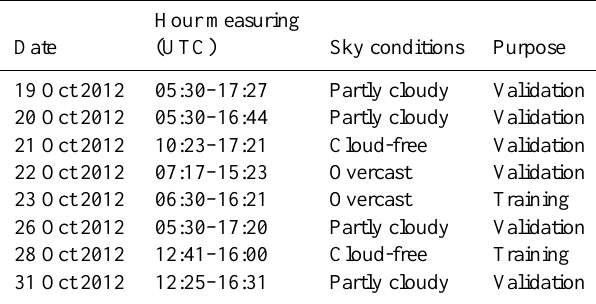
Table 1. Measuring description of the CCD spectroradiometer and the HSI system for spectral sky radiance reproduction.